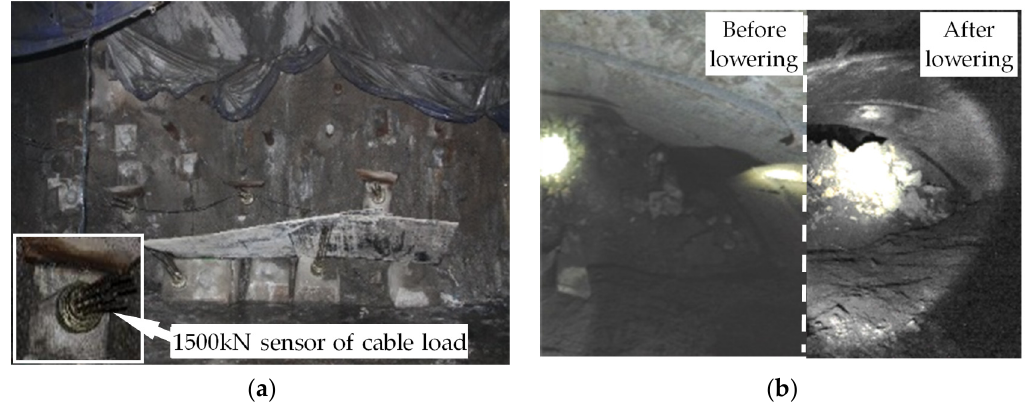
Figure 13. Plugging effect of the main ore pass: ( a ) Whole picture of plugging engineering; ( b ) Before and after ore lowering in the incline ore pass.